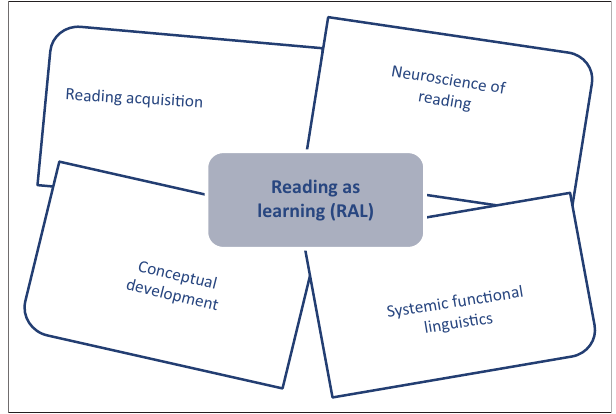
FIGURE 1: Proposed model for reading as learning